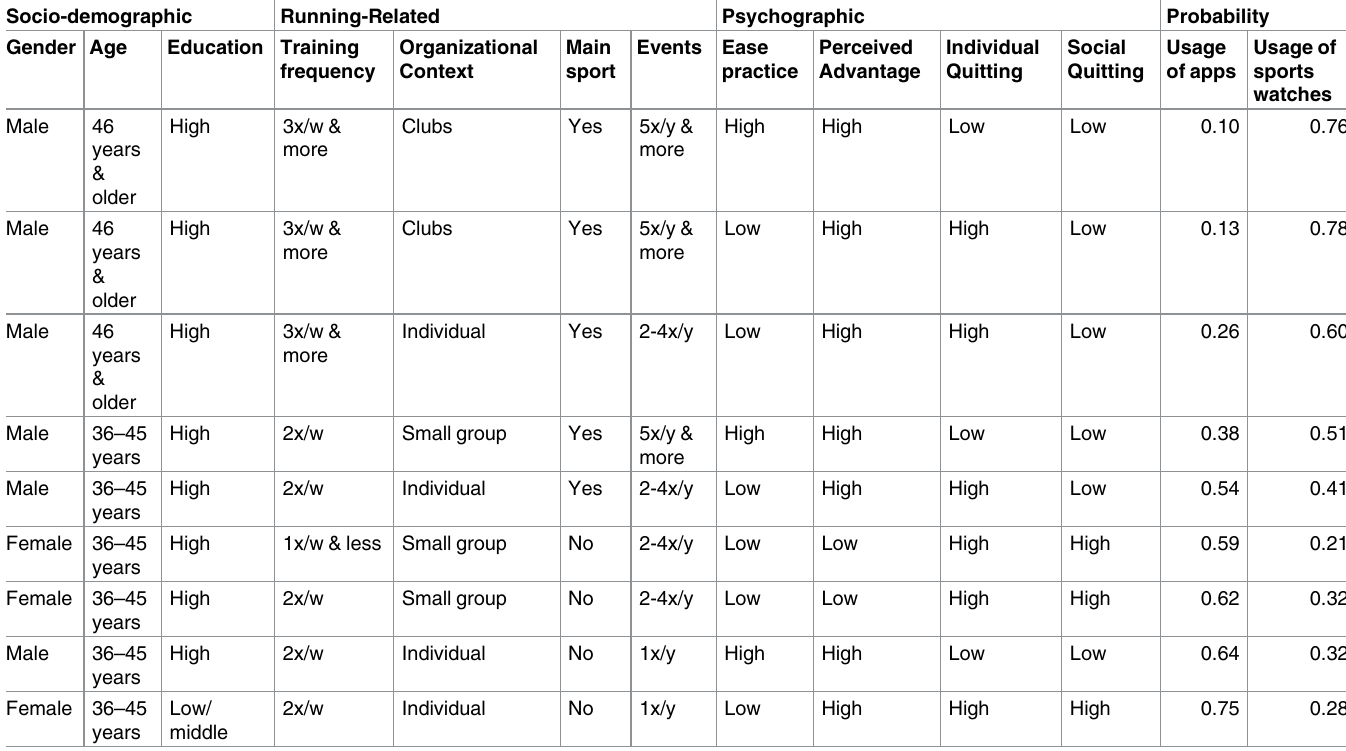
Table 7. Probability of event runners’ usage of apps and sports watches for different consumer profiles. Socio-demographic Running-Related Psychographic Probability Gender Age Education Training